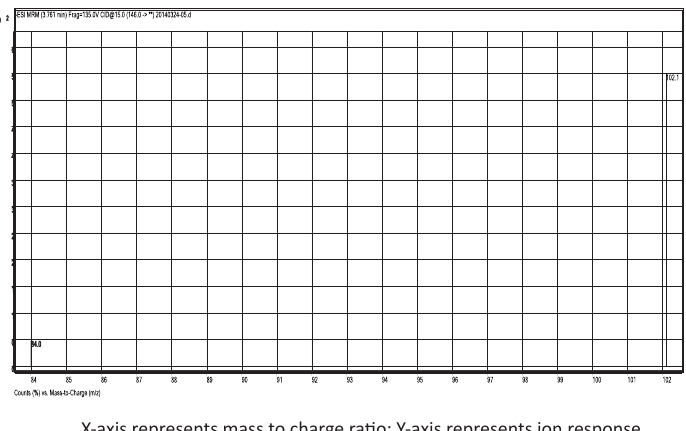
X-axis represents mass to charge ratio; Y-axis represents ion response Fig. 6. Spectrum of glutamate acid with triple quadrupole LC